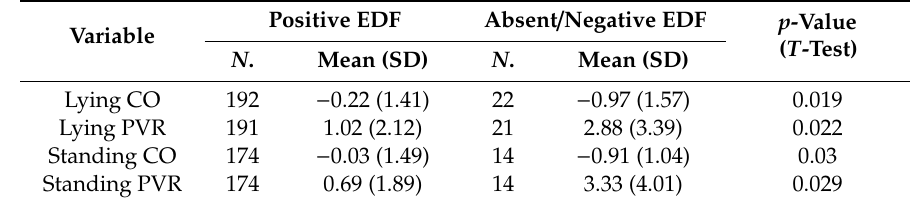
Table 3. Comparison of cardiac output and peripheral vascular resistance z -score in cases with positive end diastolic flow and cases with absent / reverse end diastolic flow in the umbilical artery.